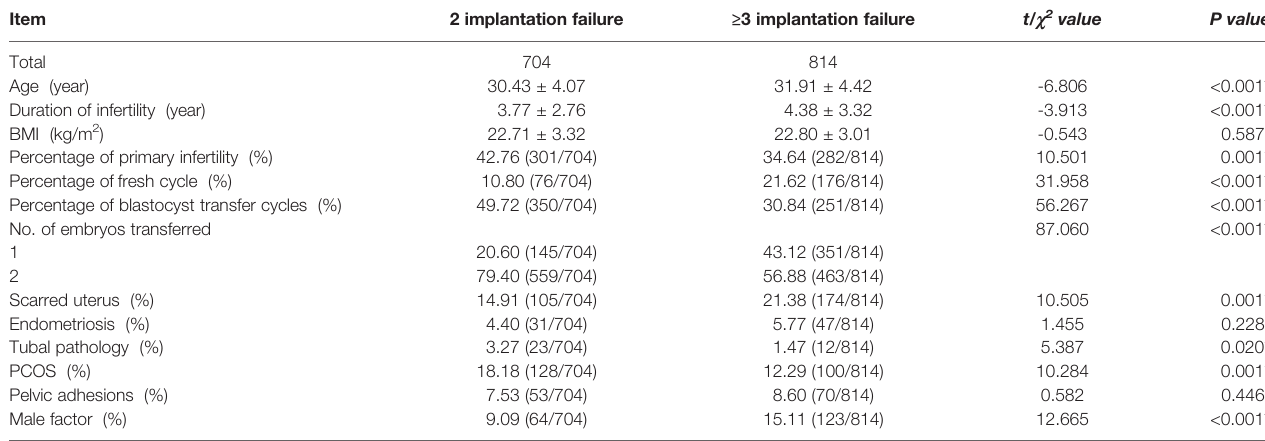
TABLE 1 | The comparison of general information and distribution of associated factors of patients with two vs three or more implantation failure.